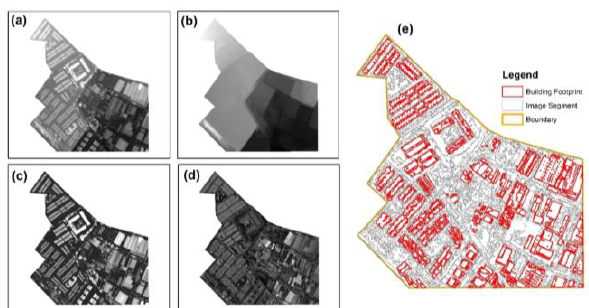
Figure 3. Input data used for building extraction and image segments, (a) LiDAR derived DSM, (b) LiDAR derived DEM, (c) Height, or nDSM, (d) Intensity, (e) Image segments and building footprints.